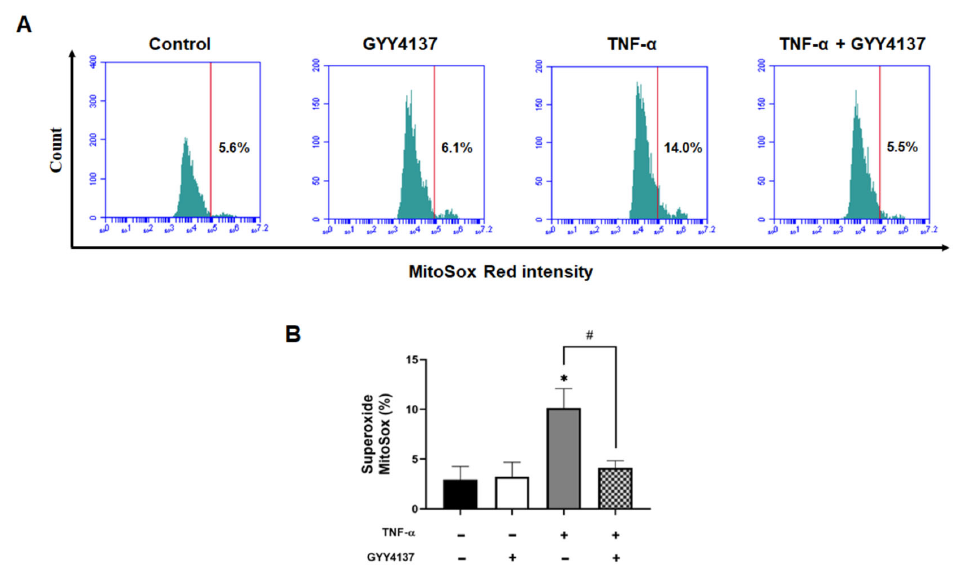
Figure 6. GYY4137 post ‐ treatment reduces oxidative stress in TNF ‐α‐ treated cells. ( A ) Representa ‐ tive flow cytometry histogram plots for MitoSox intensity and ( B ) quantification of MitoSox fluo ‐ rescence ‐ associated superoxide intensity compared to the untreated control (positive threshold was set to 2% using unlabelled cells), using 10,000 events in each replicate p ‐ values were calculated using one ‐ way ANOVA followed by Tukey’s comparison test. Data are shown as means ± SD; * p < 0.05 vs. control. # p < 0.05 vs. TNF ‐α‐ treated groups only. N = 3 independent experiments with 3 replicate in each experiment.